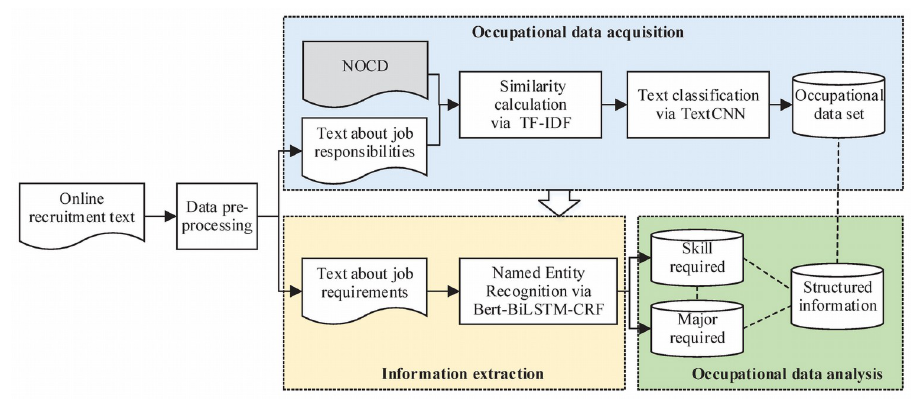
Fig 1. Flow chart of occupational portrait.